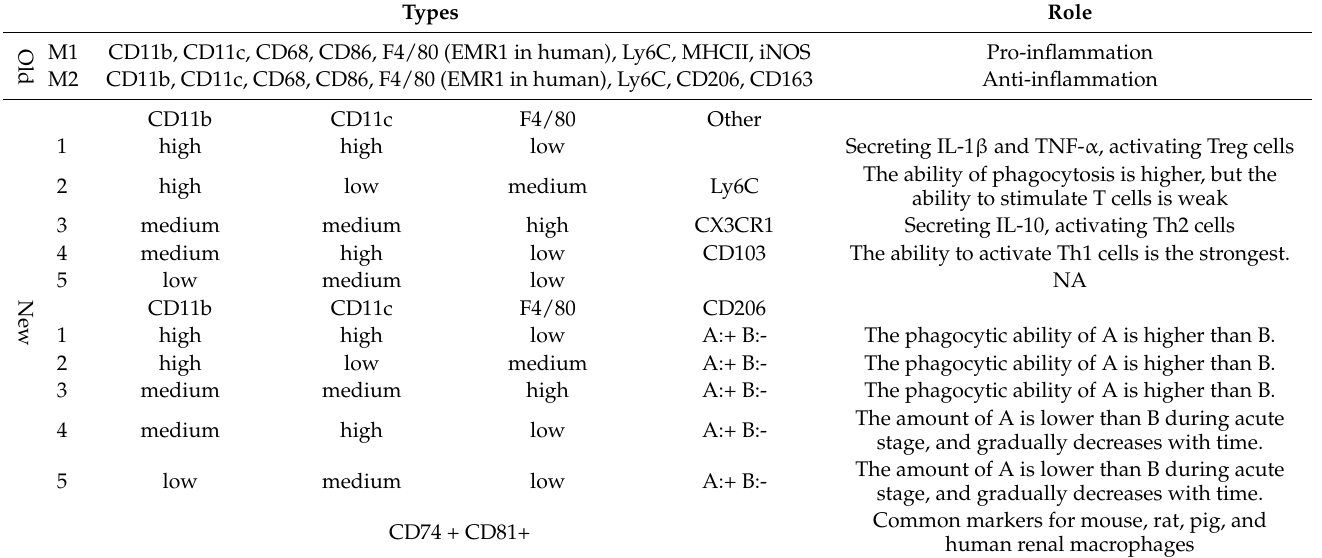
Table 1. Types of